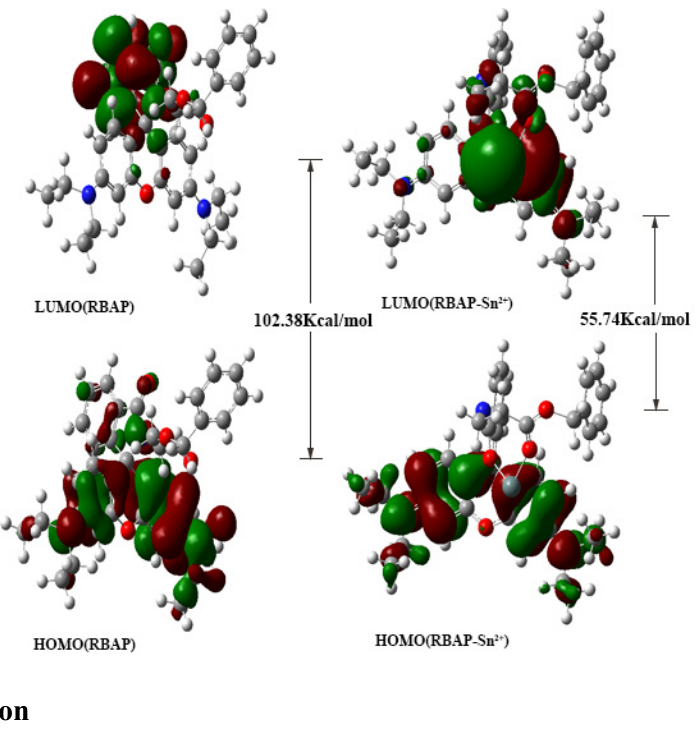
Figure 12. HOMO and LUMO orbitals of ( A ) RBAP and the ( B ) RBAP -Sn 2+